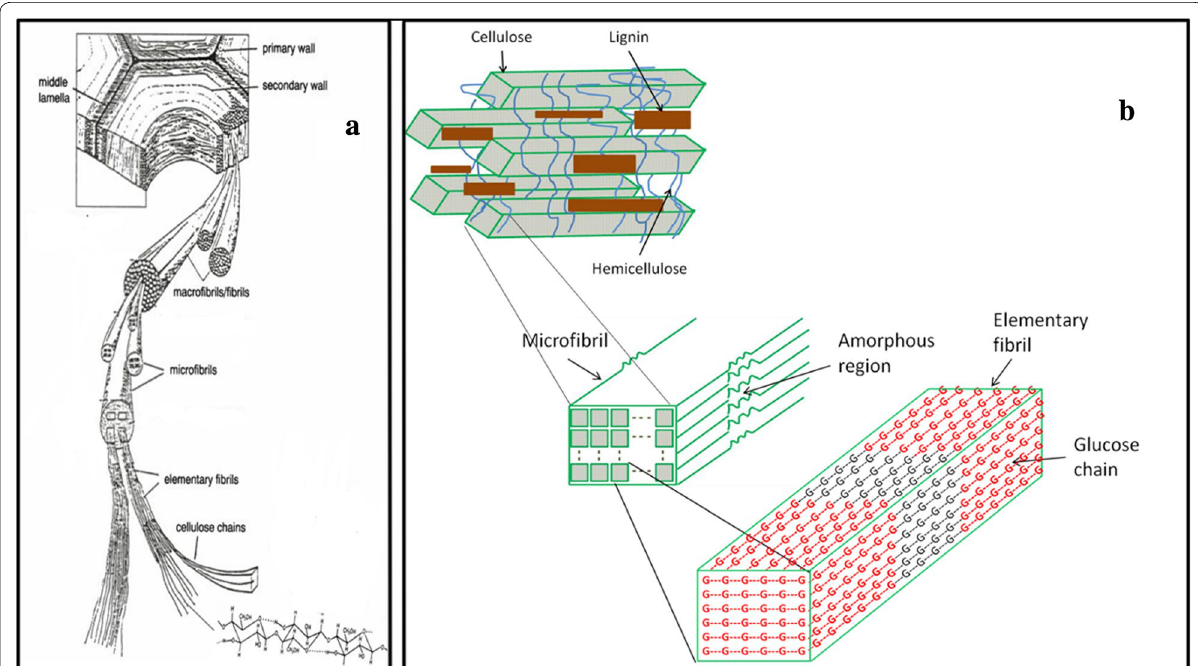
Fig. 2 Structure of cellulose: a actual cellulose structure; b structure of cellulose simulated in model. Glucose molecules in red color represent crystalline region and glucose molecules in black color are in amorphous region. (Adapted from Kumar